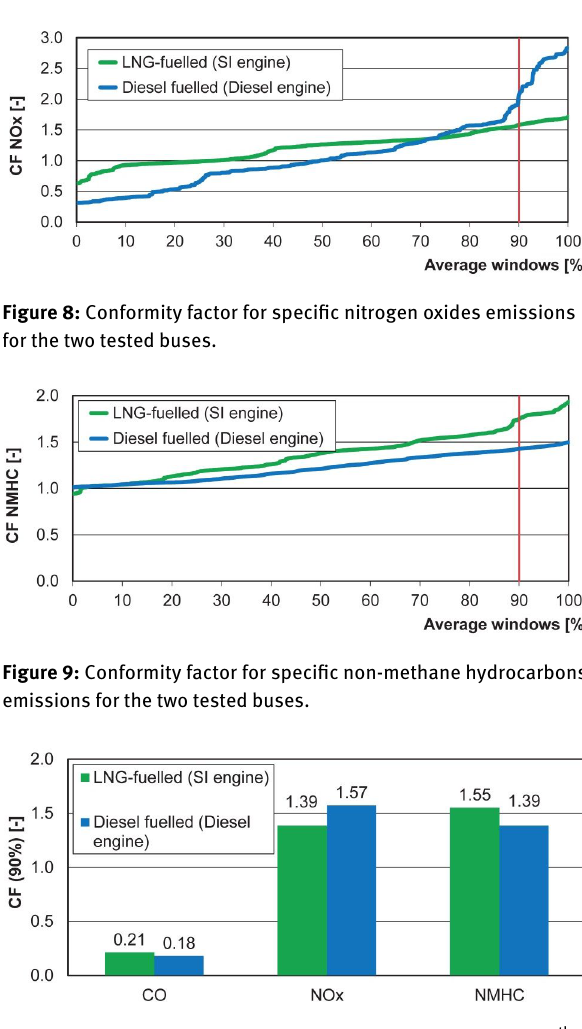
Figure 10: The conformity factors value corresponding to the 90 th percentile for the measured exhaust components (permitted limit value of CF =